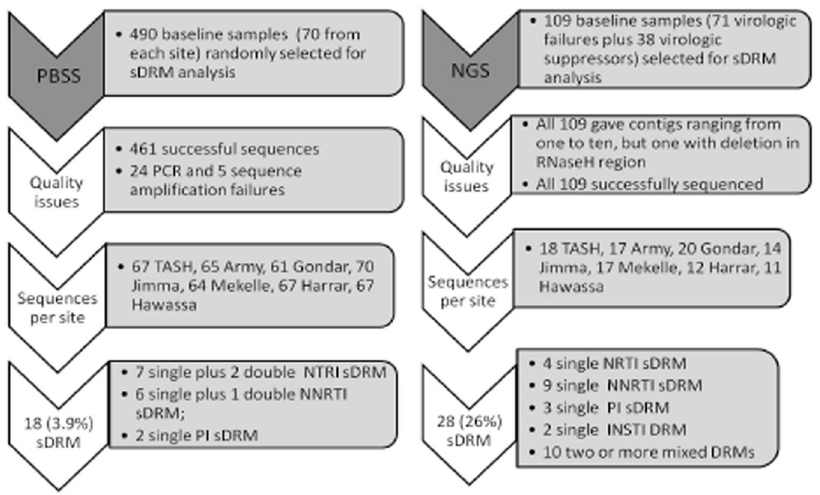
Figure 1. Study profile of patients. PBSS: population-based Sanger sequencing; NGS: next generation sequencing. NRTI: nucleoside analogue reverse transcriptase inhibitors; NNRTI: non-nucleoside RTI; PI: protease inhibitors; INSTI: integrase inhibitors. DRM: drug resistance mutations (surveillance drug resistance mutations were described for NRTI, NNRTI and